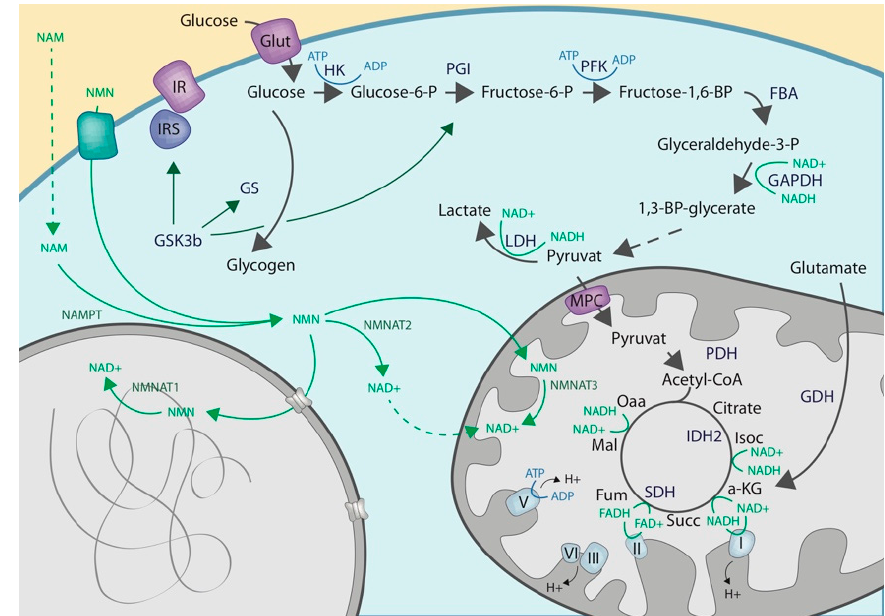
Figure 1. Schematic overview over the main metabolic hubs comprising the central carbohydrate metabolism. Gycolysis, TCA cycle and oxidative phosphorylation are depicted in black (black arrows), while enzymes involved in those processes are depicted in dark blue. NAD + metabolism, including synthesis and consumption is depicted in green (green descriptions and arrows), while ADP / ATP conversions are depicted in light blue. Glucose-6-phosphate (Glucose-6-P), fructose-6-phosphate (Fructose- 6-P), fructose-1,6-bisphosphate (Fructose-1,6-BP), glyceraldehyde-3-phosphate (Glyceraldehyde-3-P), oxaloactetate (OAA), isocitrate (Isoc), a-ketoglutarate (a-KG), succinate (Succ), fumarate (Fum), malate (Mal), hexokinase (HK), phosphoglucoisomerase (PGI, phosphofructokinase (PFK), aldolase (FBA), lactate dehydrogenase (LDH), pyruvate dehydrogenase (PDH), glutamate dehydrogenase (GDH), insulin receptor (IR), insulin receptor signaling (IRS).